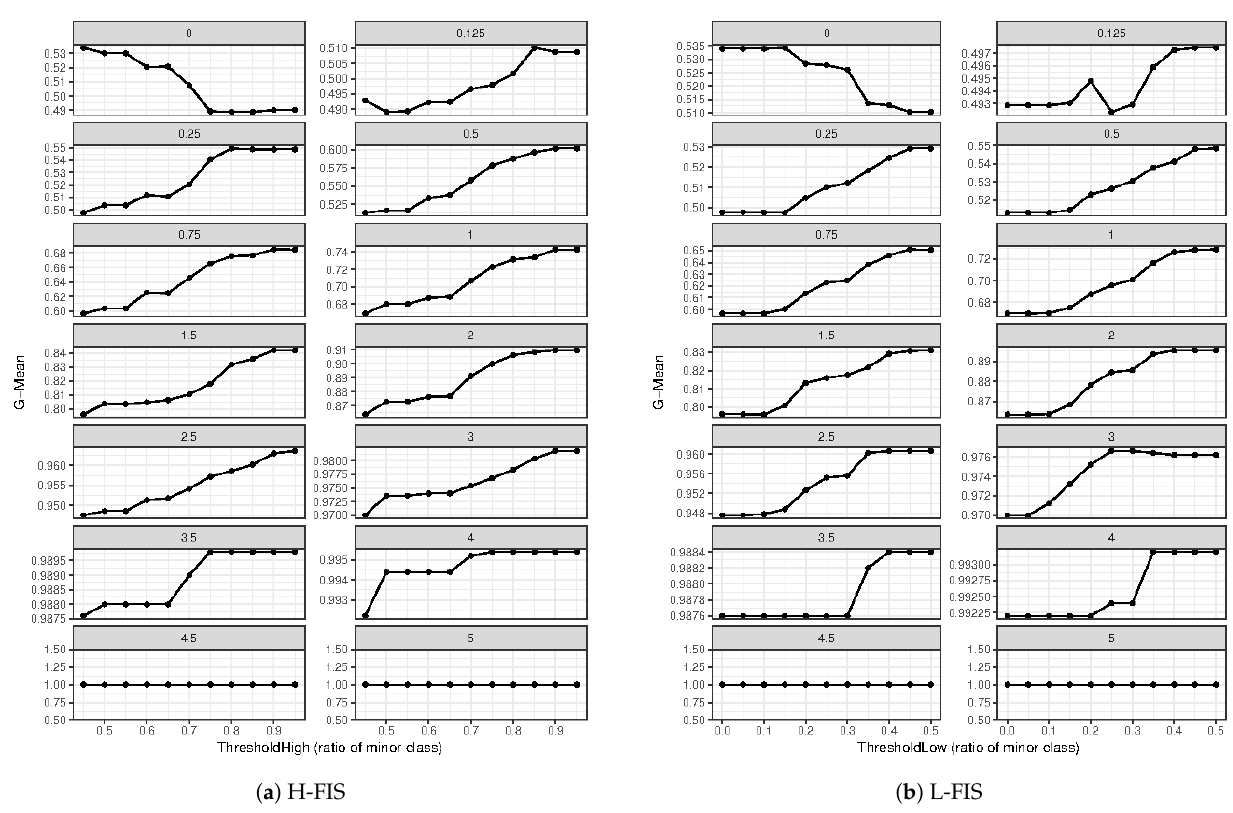
Figure 5. Graphs that represent the effect of the H-FIS ( a ) and L-FIS ( b ) on G-Mean in the artificial datasets as we adjust the process to be more aggressive in the removal of points. The point to the left of the graph represents the initial point without